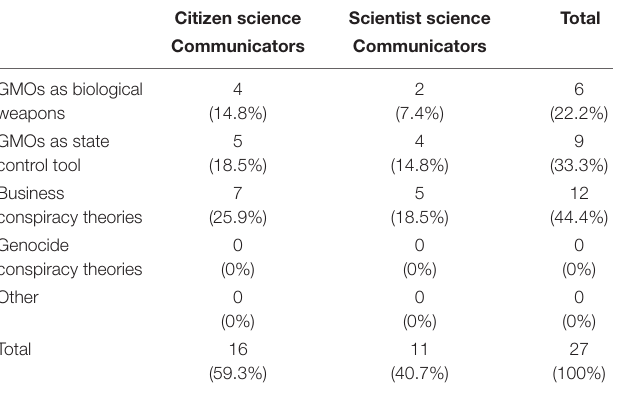
TABLE 2 | Frequency of discussion about different GMOs conspiracy theories on